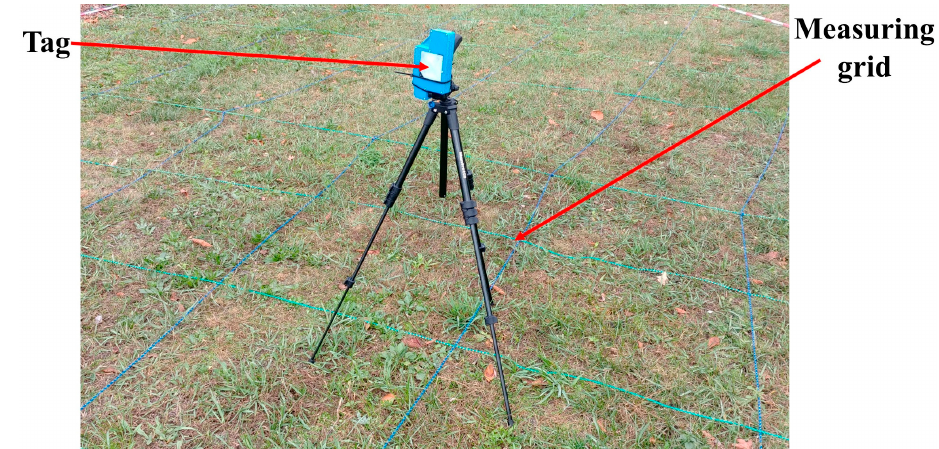
Figure 5. Tag on the measurement grid.